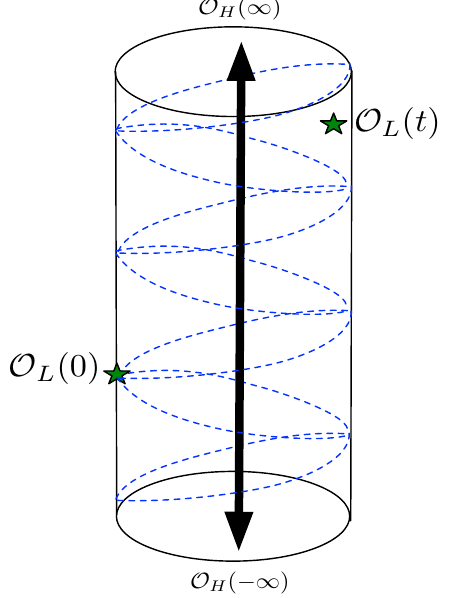
Figure 1 . This (cid:12)gure depicts a generic con(cid:12)guration of the Lorentzian heavy-light correlator, with dashed lines drawn in to indicate past and future lightcones emanating from the operator The lightcones appear as branch cuts in CFT